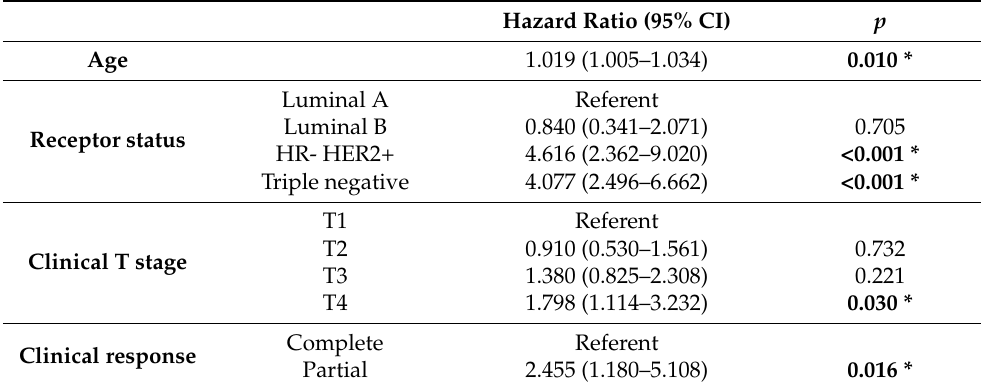
Table 4. Final step of the backward conditional Cox multivariate regression analysis for predictors of overall survival in the unmatched dataset of ypN+ patients ( N = 1151). CI: Confidence Interval. * Statistically